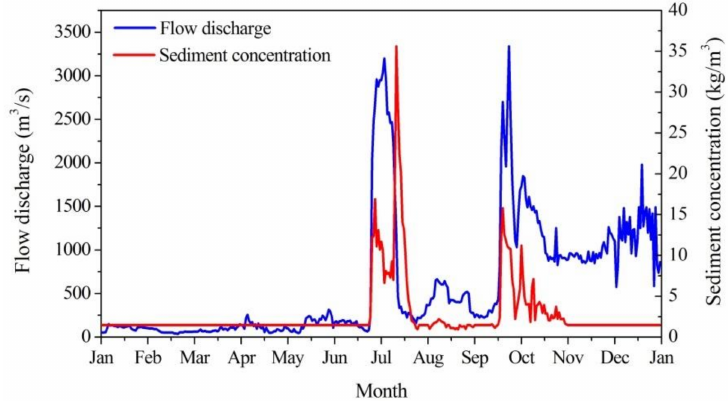
Figure 14. Time series of the Yellow River flow discharge and sediment concentration at Lijin hydrological gauging station in 2011. The flow discharge distribution had two high peaks from late June to early July and from late September to early October, respectively, which was mainly due to reservoir’s flood relief in the Yellow River